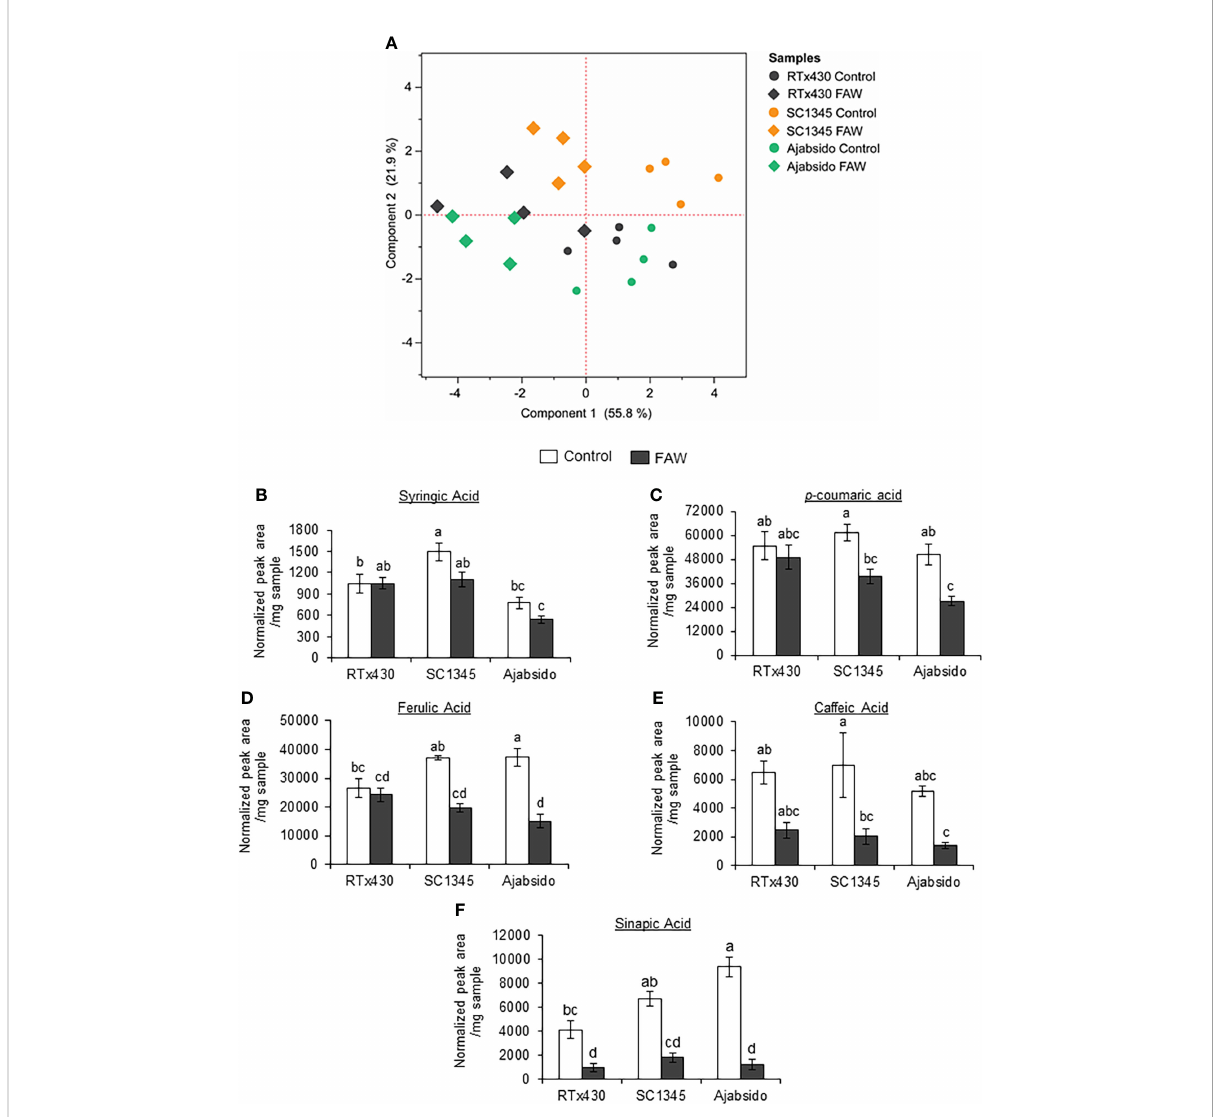
FIGURE 3 Fall armyworm (FAW) feeding suppressed the accumulation of phenolic intermediates of the monolignol biosynthetic pathway in sorghum. (A) Principal component analysis (PCA) of soluble and cell-wall bound phenolic compounds quanti fi ed by GC-MS after 10 days of FAW infestation on RTx430, SC1345 and Ajabsido plants. FAW-uninfested plants were used as controls. (B – F) Relative abundances of intermediates of the monolignol biosynthetic pathway were determined by GC/MS analysis of soluble phenolics extracted from sorghum leaves. Peak area was normalized to the internal standards using 4-methyl cinnamic acid for soluble phenolics. The relative abundances of soluble (B) syringic acid, (C) p -coumaric acid, (D) ferulic acid, (E) caffeic acid, and (F) sinapic acid are presented (n = 4). Error bars represent ± SE. Different letters indicate signi fi cant difference relative to each other ( P <